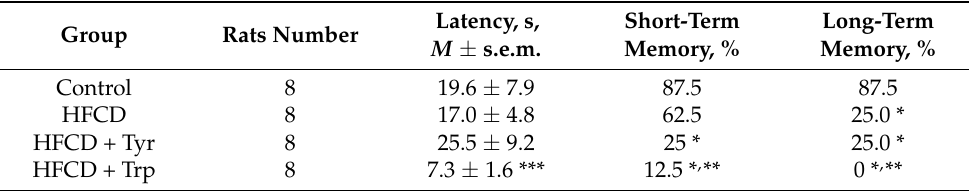
Table 1. Behavioral reactions of rats in the CRPA test.